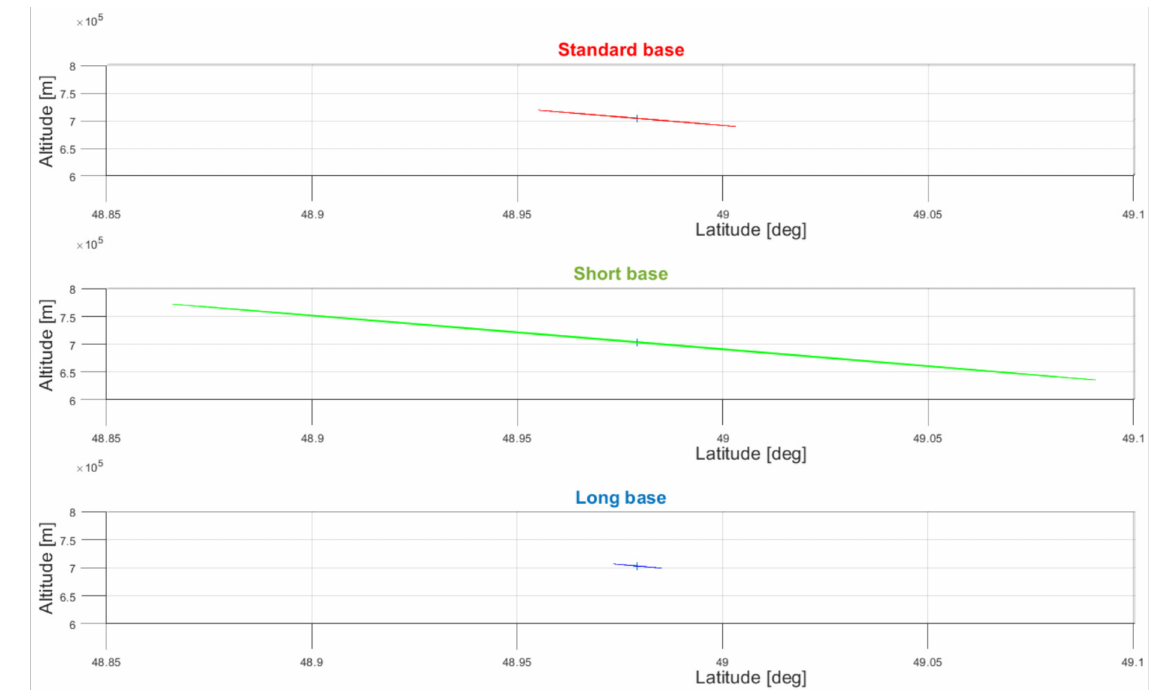
Figure 16. Sections of error ellipsoids in latitude to altitude plane (2D).